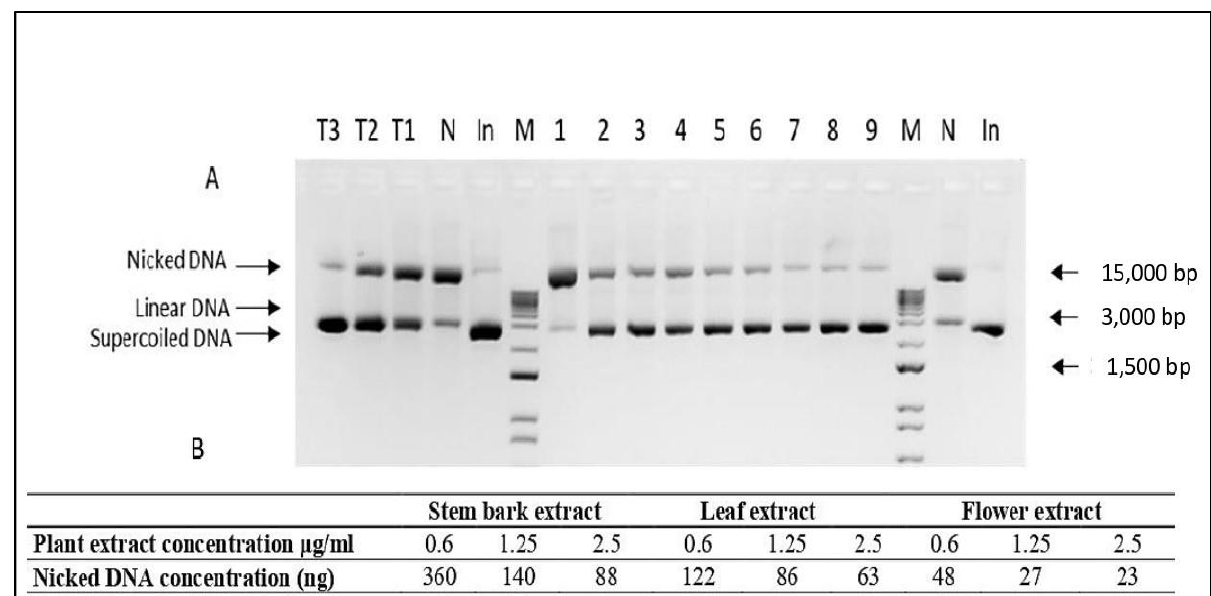
Figure 1. DNA nicking protection assay with ( A ) 1.5% agarose gel electrophoresis, and ( B ) relative concentration of necked plasmid DNA. 1–3— A. altissima stem bark extract at concentrations of 0.6, 1.25, and 2.5 µ g/mL; 4–6— A. altissima leaf extract at concentrations of 0.6, 1.25, and 2.5 µ g/mL; 7–9— A. altissima flower extract at concentrations of 0.6, 1.25, and 2.5 µ g/mL. T3—Trolox 100 µ g/mL;